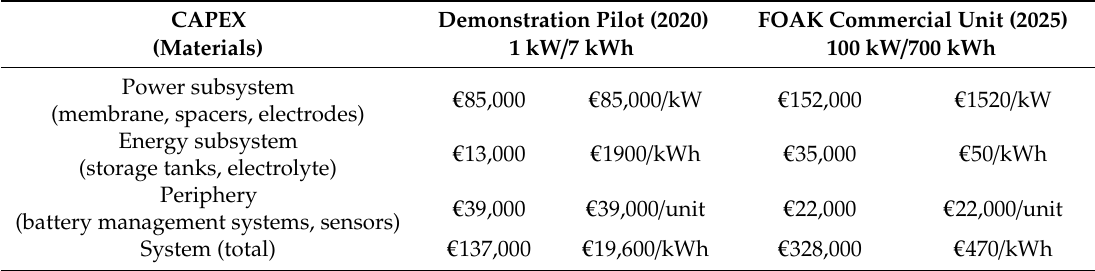
Table 4. Capital expenditure (CAPEX) of current pilot-scale plant (1 kW / 7 kWh), and cost